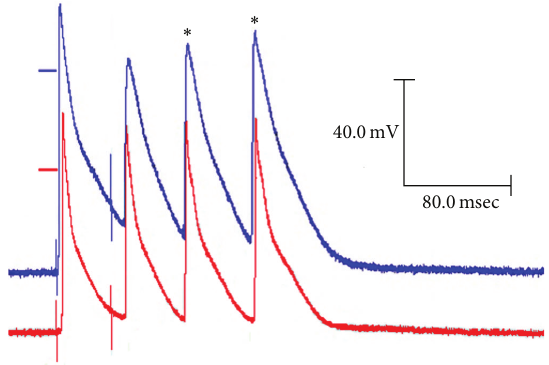
Figure 9: Reentrant activity initiated by the application of an early extrasystole. The traces shown correspond to action potentials recorded in the papillary muscles of diabetic rats, in the area proximal (upper trace) and the area distal (lower trace) to the stimulation site, at a basic cycle of 500 milliseconds. Observe that, after the implementation of the extrasystole, two responses (asterisks) not evoked by stimulation appear, corresponding to a type of reentrant activity.